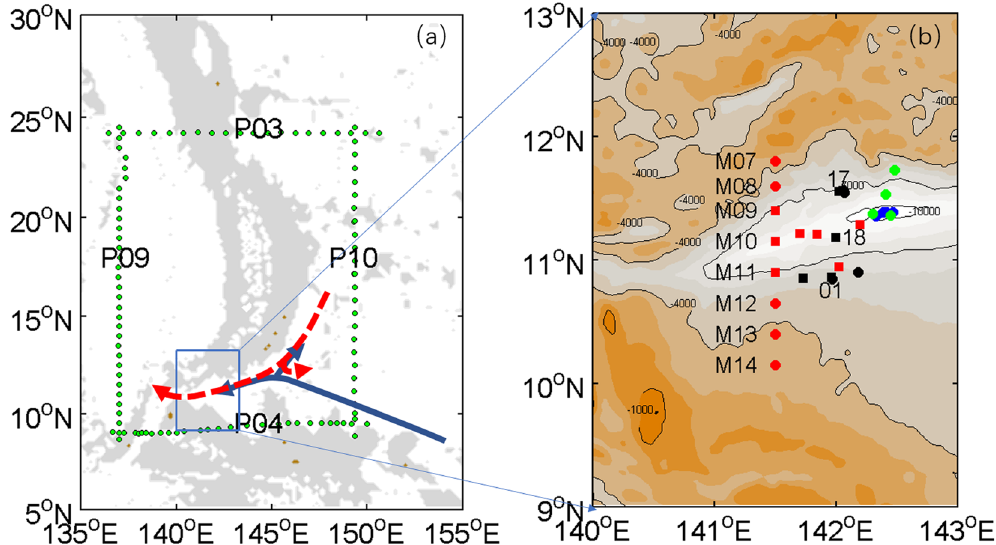
Figure 1. Bathymetry and locations of stations. ( a ) The transects P09, P04, P10, and P03 are CTD transects obtained from WOCE. The blue solid and red dashed arrows show the two viewpoints regarding the deep circulation near the Mariana Trench. The grey areas indicate depths between 0 and 4000 m. ( b ) The CTD stations of 2016S1, 2016S2, 2016W, and 2015W are indicated by black squares and circles, red squares and circles, blue circles, and green circles, respectively. Maps were generated using MATLAB.